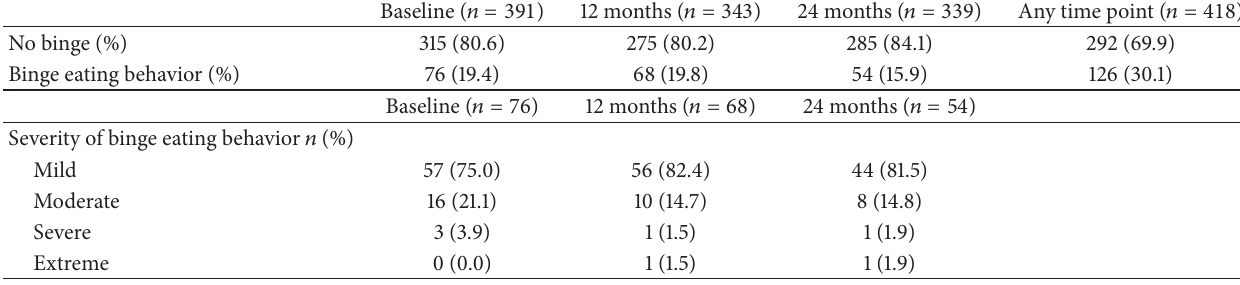
Table 2: Number and percentage of participants self-reporting binge eating behaviors by evaluation time point and severity.